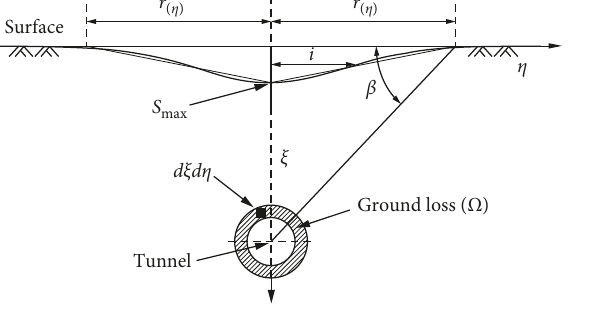
Figure 1: Surface settlement curve. Figure 2: Schematic diagram of over-excavation unit